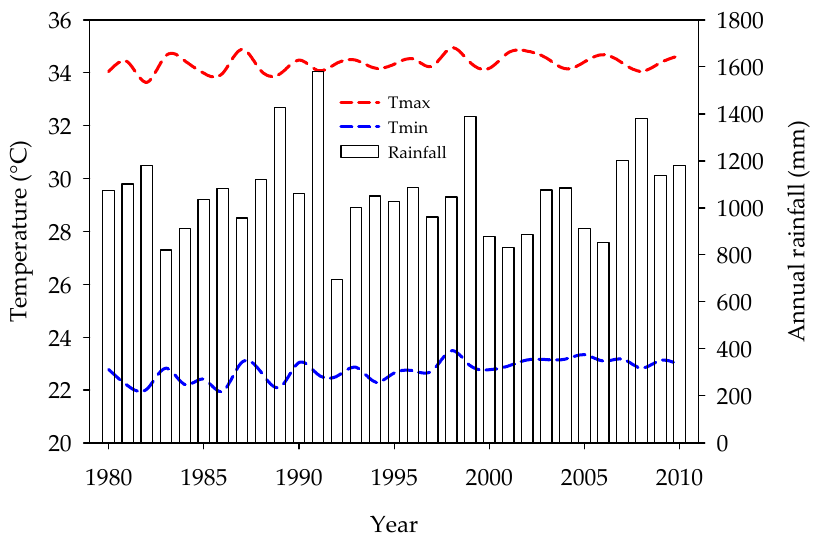
Figure 2. Historical (1980–2010) yearly average maximum and minimum temperatures and total annual rainfall of the study site.